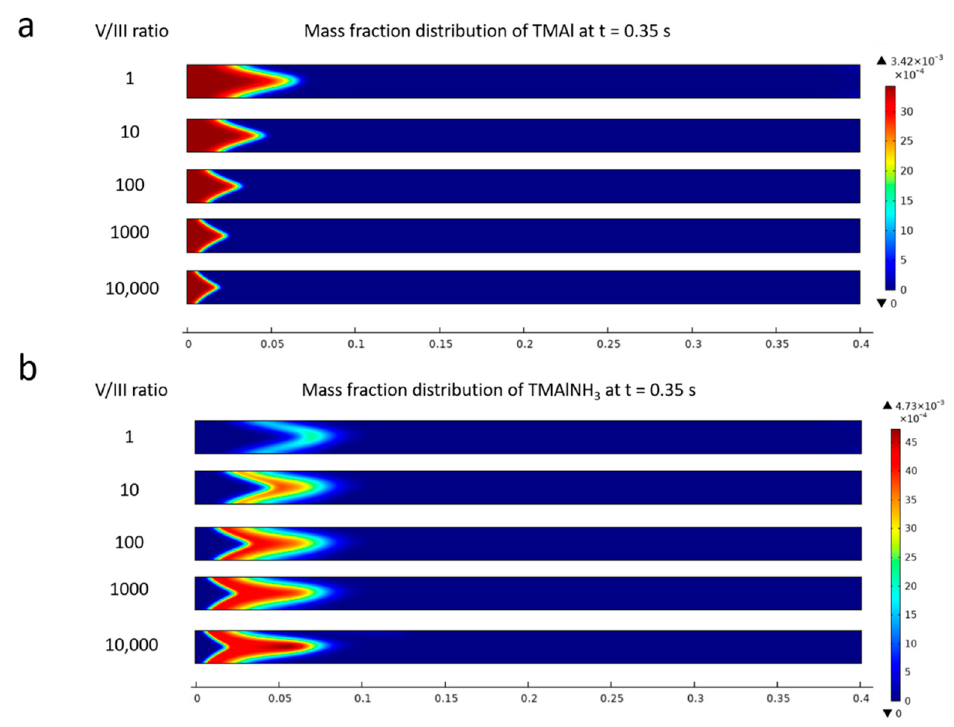
Figure 5. Mass fraction distributions of ( a ) TMAl and ( b ) TMAlNH 3 at 0.35 s for different V/III ratios.